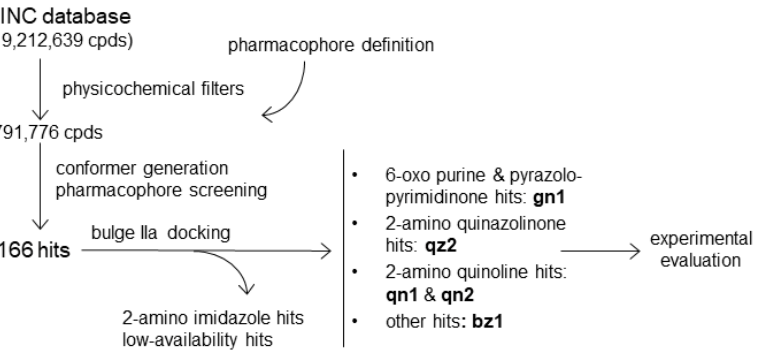
Figure 2. Scheme showing the pharmacophore-based screening process applied to identify new conformational modulators of HCV RNA subdomain IIa.